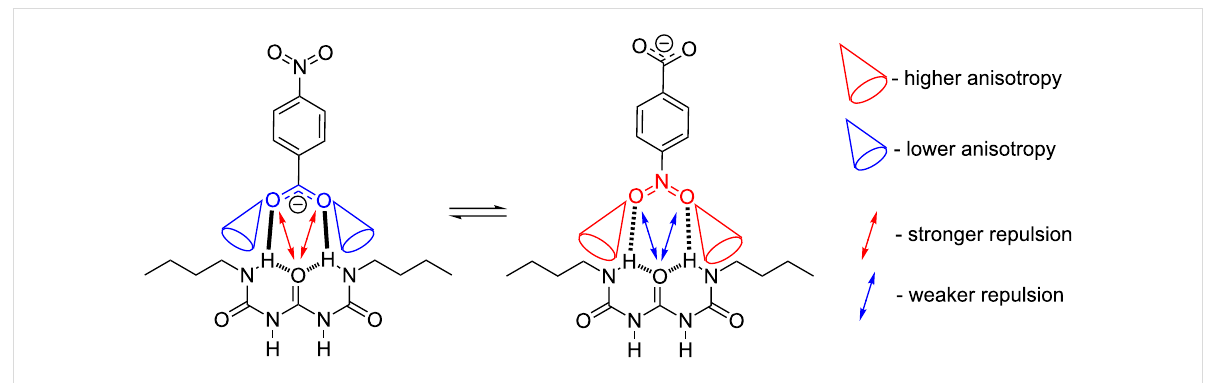
Figure 5: The proposed structure explaining unusual behavior of the titration curve for 1 ∙∙∙ 9 titration and anisotropy influence on methylene chemical shift.